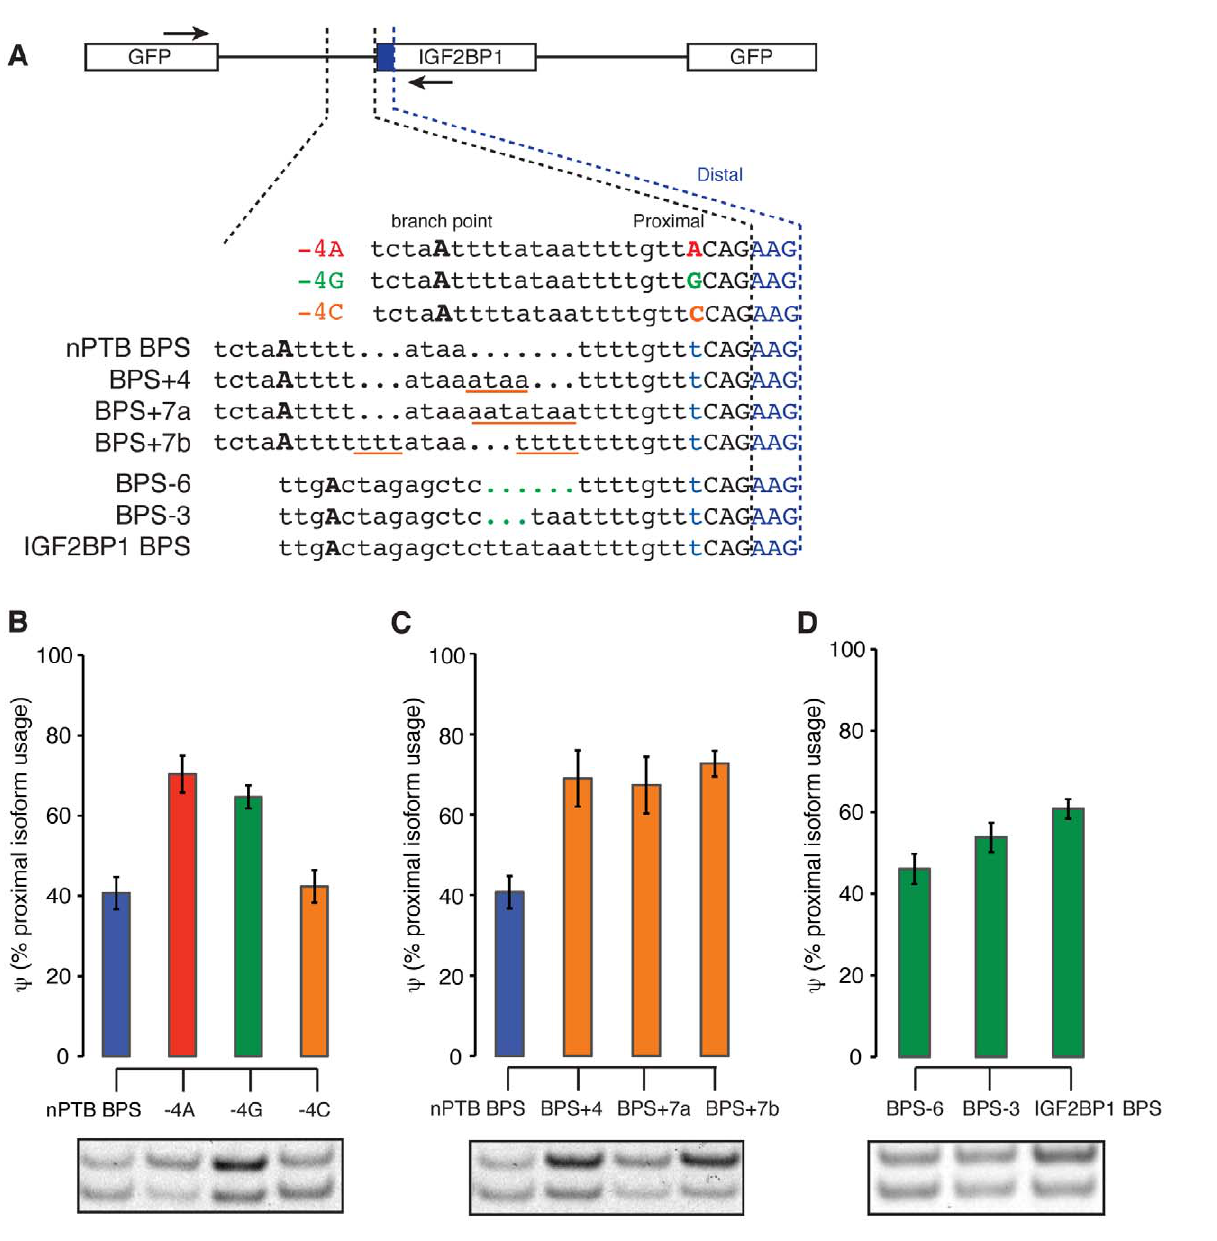
Figure 4. Specific intronic sequence features regulate NAGNAG splicing. (A) Illustration of NAGNAG minigene constructs, designed to test the roles of the branch point to 3 9 splice site distance and of the 2 4 base in NAGNAG splicing. A short segment of intronic sequence spanning the branch point to the 3 9 splice site of the PTBP2 NAGNAG was cloned upstream of the IGF2BP1 exon. To confirm the importance of a pyrimidine at the 2 4 position for distal NAG use, the effects of all four nucleotides at the 2 4 position were tested. The branch point to 3 9 splice site distance was varied by introducing nucleotides (underlined in orange) in constructs containing the PTBP2 branch point sequence, or by removing nucleotides (indicated by green dots) in constructs containing the IGF2BP1 branch point sequence. Locations of RT-PCR primers are indicated by arrows. (B) Proximal isoform expression increased dramatically after the introduction of a purine at the 2 4 position. Splicing was monitored after minigene transfection into HEK293T cells by RT-PCR. Mean and standard deviation of at least three independent transfections are shown. A representative gel is shown below (top and bottom bands represent proximal and distal isoforms, respectively). (C) As in (B), but varying the branch point to 3 9 splice site distance in the context of the native nPTB branch point sequence. The distance was increased by insertion of four or seven nucleotides of sequence of varying purine/pyrimidine composition as shown in (A). (D) As in (C), but decreasing the branch point to 3 9 splice site distance in the context of the exogenous IGF2BP1 BPS by deletion of three or six bases as shown in (A). used in human. By contrast, 50%–85% of human, mouse, and coding genes, we detected alternative splicing (both isoforms Drosophila YAGYAGs were detected as alternatively spliced, expressed at $ 5% in at least one developmental time point) for suggesting that NAGNAG alternative splicing is substantially only 18% of NAGNAGs with favorable pyrimidine bases at both 2 3 positions based on RNA-Seq read depths slightly below those rarer in worms than in other metazoans. This decrease in